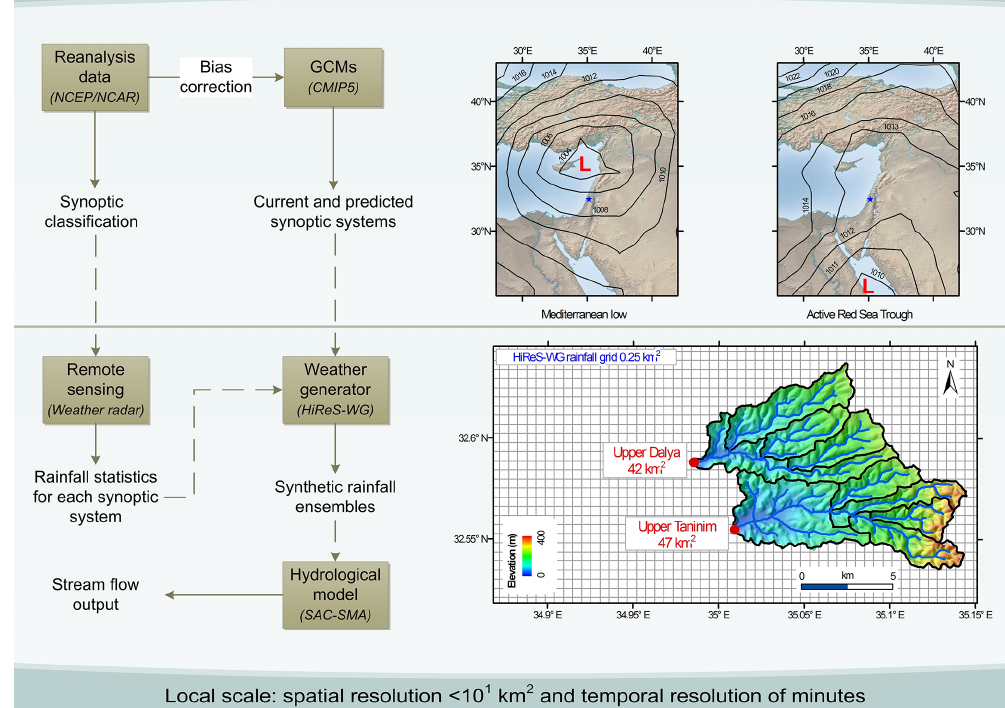
Figure 1. A framework flow chart (left) for assessing the sensitivity of the hydrologic regime to climate change. Models mentioned in parenthesis (italic caption) relate to the models or methods used for the case study of upper Dalya and upper Taninim catchments. The catchments are presented in the lower right side (red dots represent the hydrometric stations) and the prevailing two wet synoptic systems affecting the region are presented in the upper right side (contours represent sea level pressure inhPa, blue star indicate the catchments